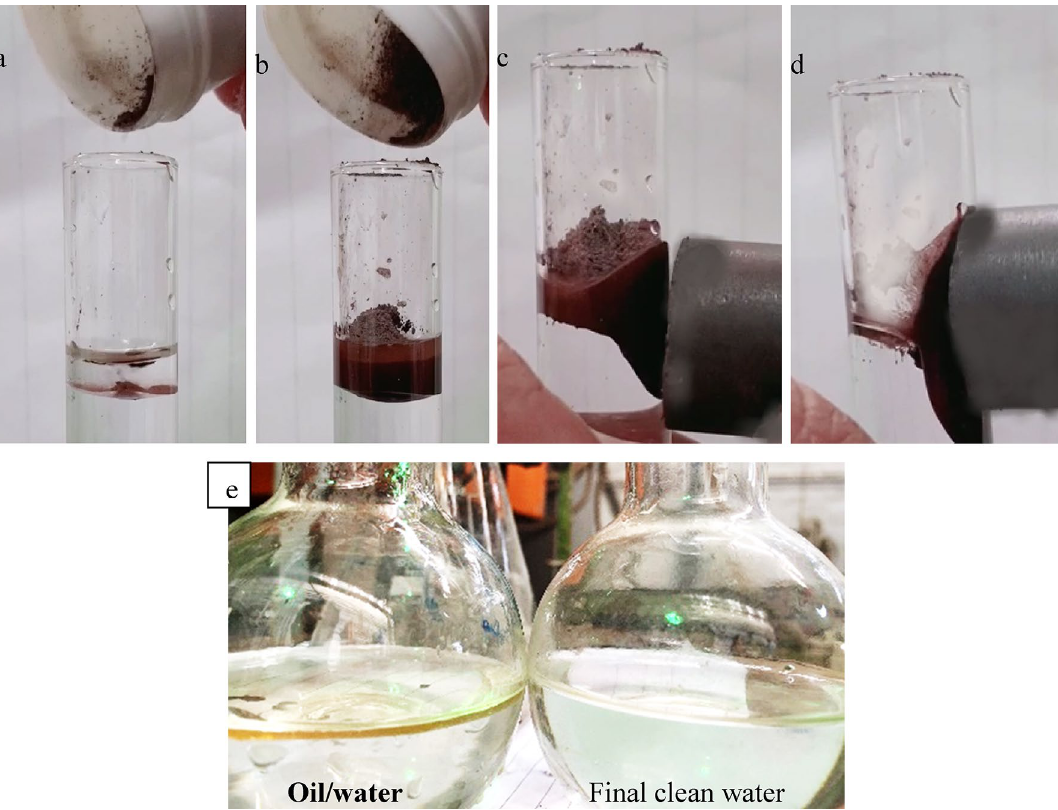
Figure 8. Oil/water separation using ZS@BIF composite ( a ) oil layer above water, ( b ) adding superhydrophoic magnetic composite, ( c ) magnet approaching the oil/composite layer, and ( d ) oil/composite layer attracted to an external magnetic field, ( e ) Image before and after oil/water separation using ZS@BIF